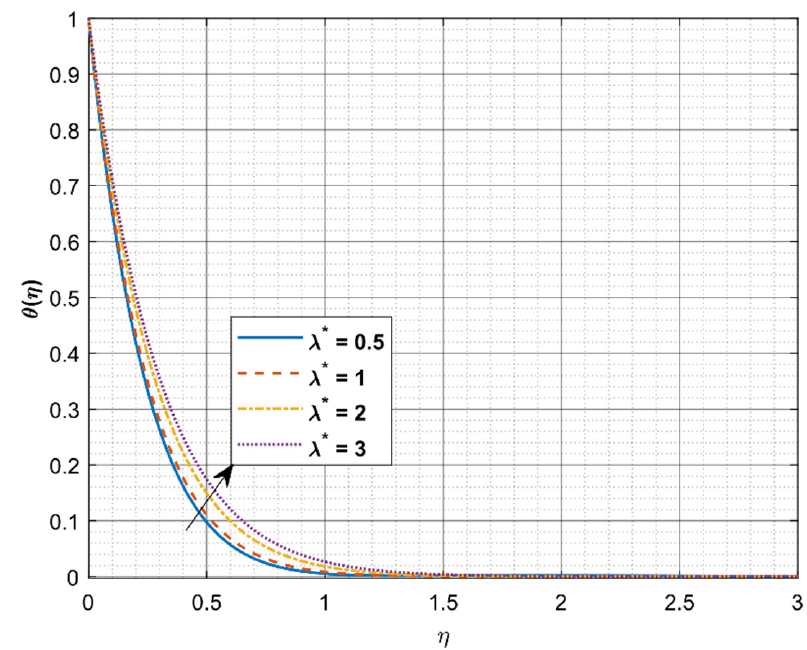
Figure 5. Influence of λ ∗ on θ ( η ) . The levering of Ma on f (cid:48) ( η ) is shown in Figure 6. The graphed figure reveals that increasing the values of Ma improves the velocity gradient. This behavior is due to the variation in surface tension. Meanwhile, the Marangoni effect is a pouring force for